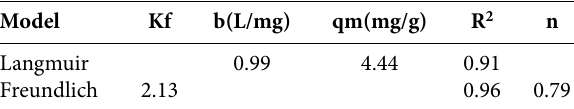
Table 1. Parameters related to the adsorption